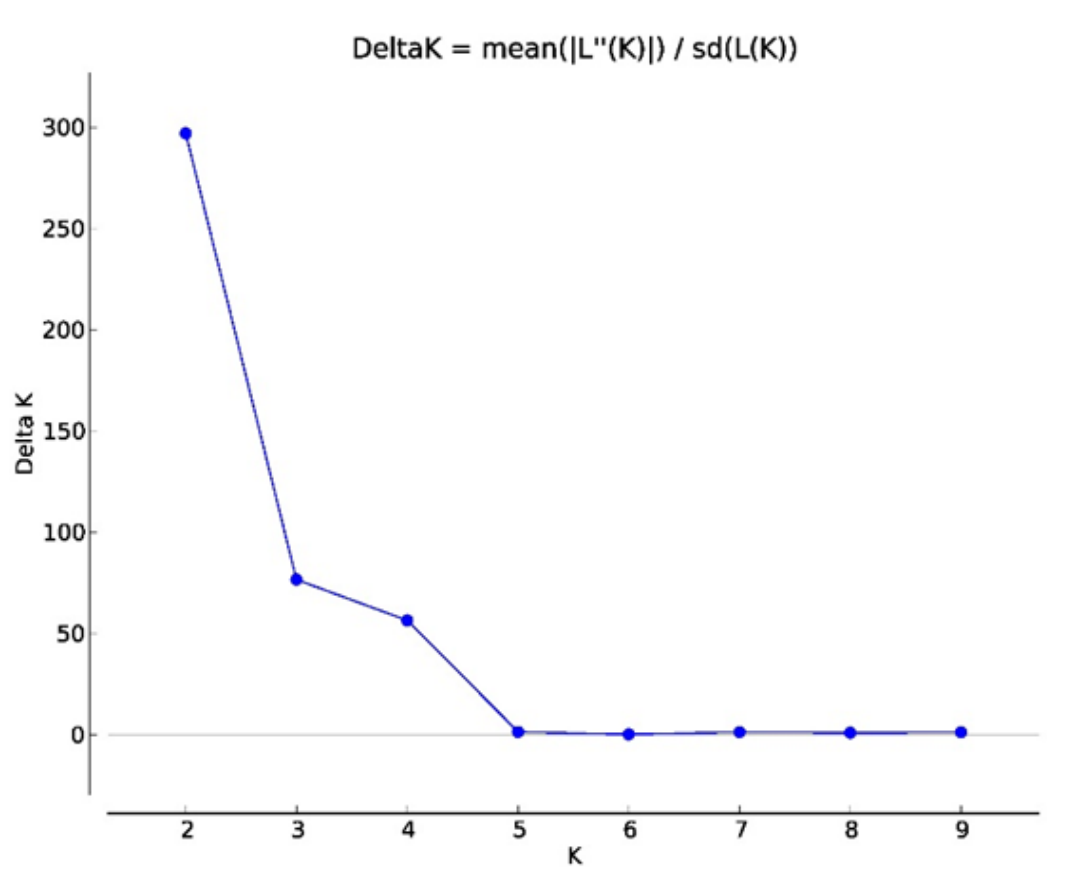
Figure 4. Number of K groups (true K ) derived from 252 loci of 100 Dyera polyphylla